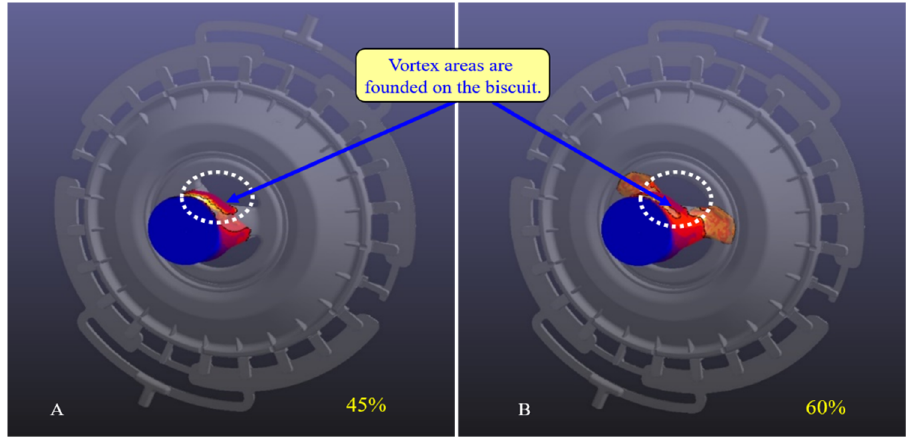
Figure 6. Simulation results of the melt flow for case 2: ( A ) 45% filling; ( B ) 60% filling.